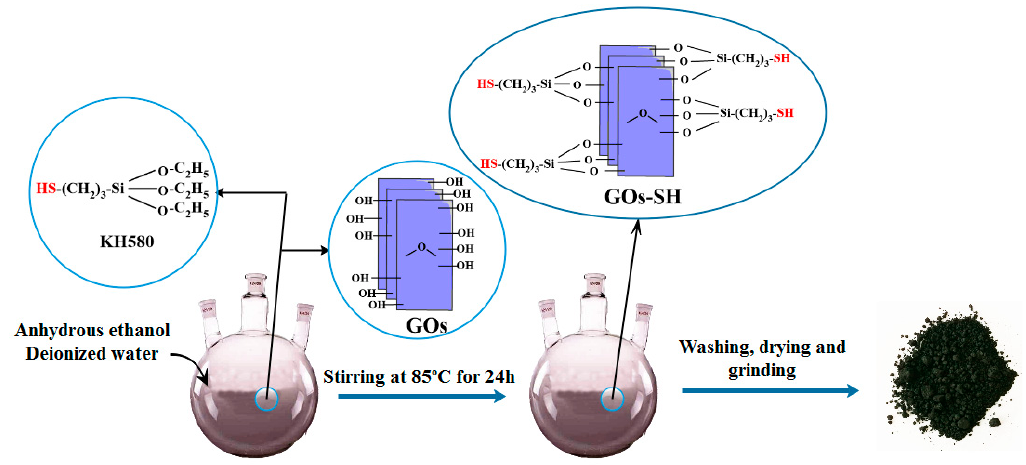
Figure 1. Schematic representation of synthesis process of GOs-SH.